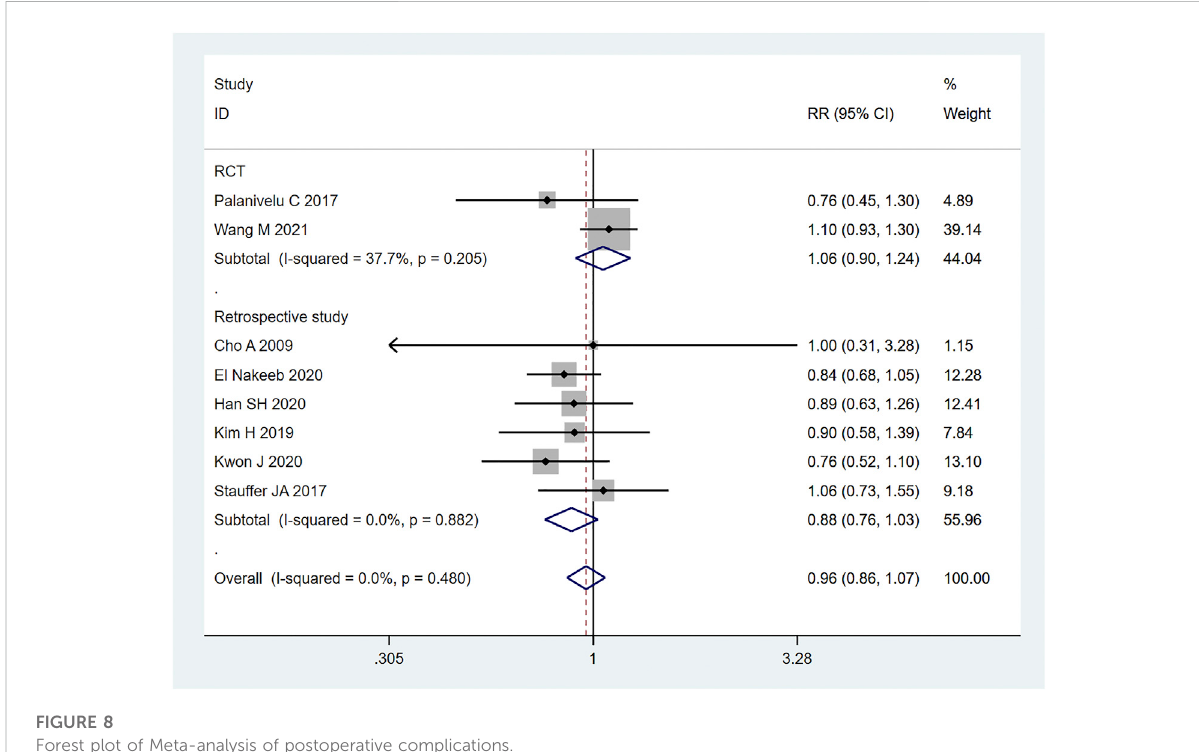
FIGURE 8 Forest plot of Meta-analysis of postoperative complications.